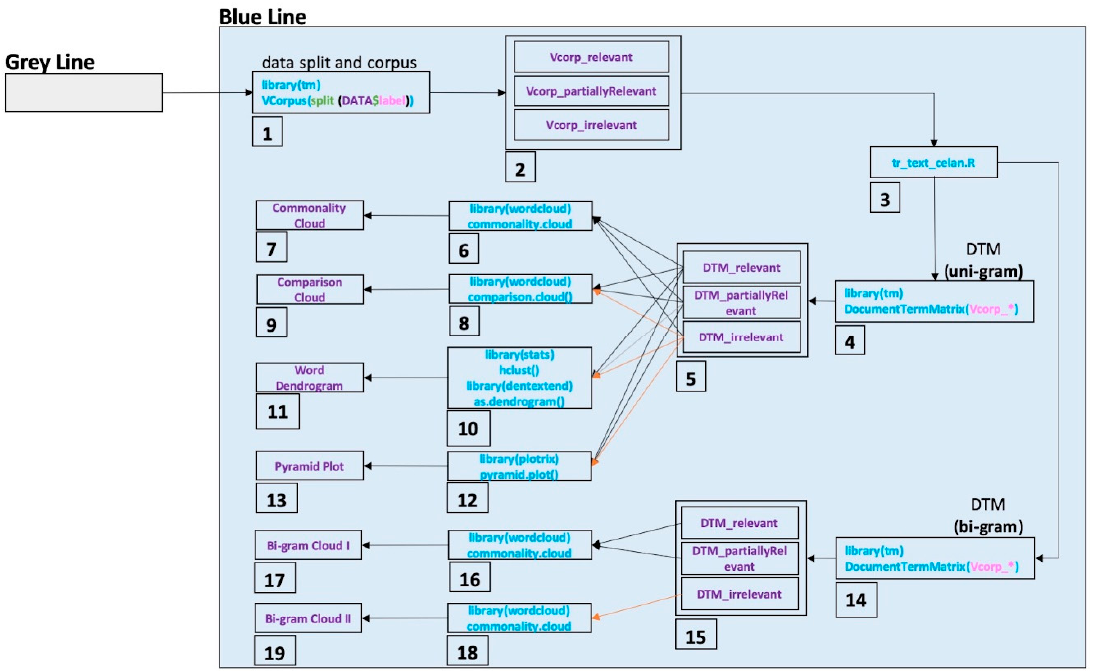
Figure 3. The blue line for data exploration.